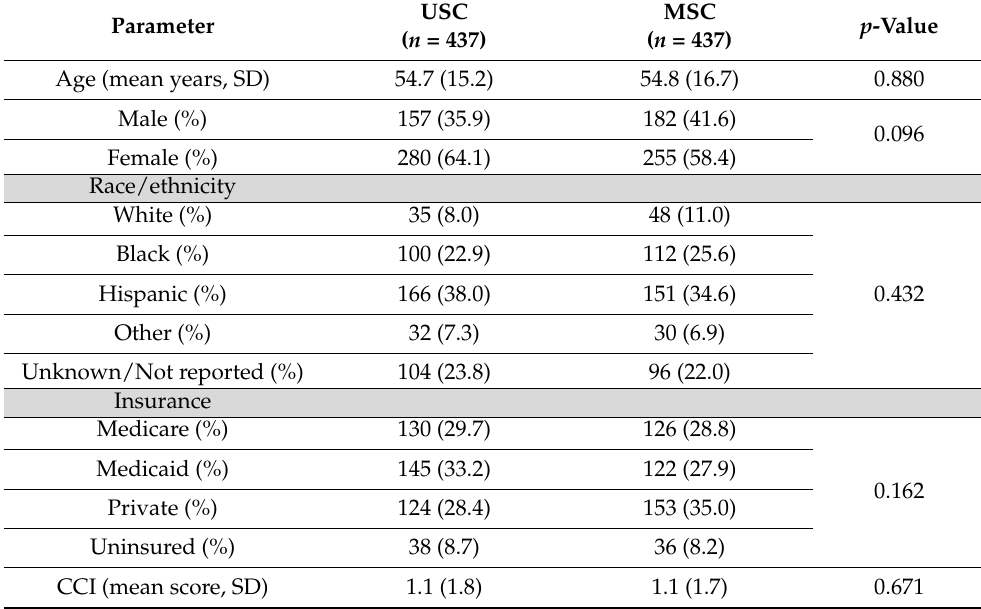
Table 2. Propensity score-matched analysis of baseline and socioeconomic characteristics in patients seen at the Unidisciplinary Spine Clinic (USC) and Multidisciplinary Spine Clinic (MSC). Parameter